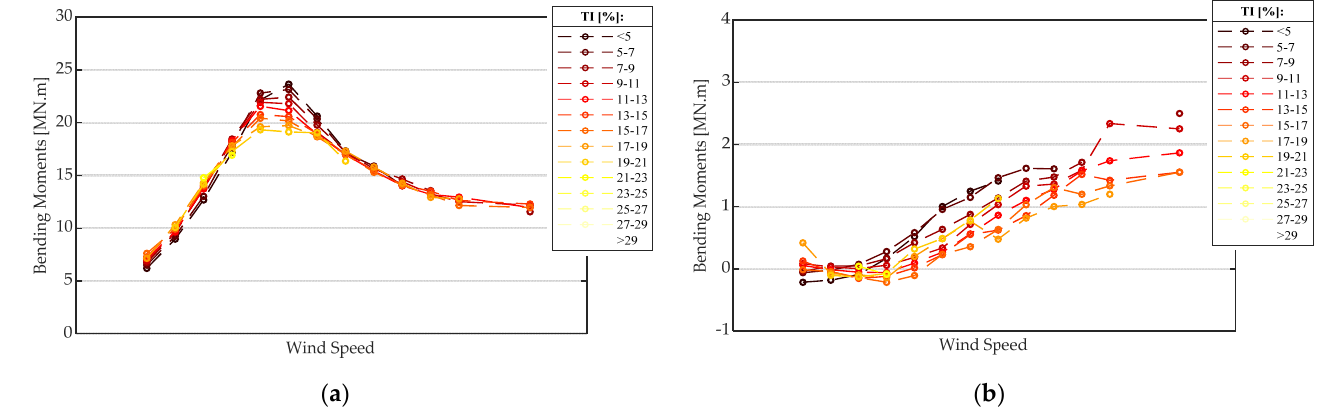
Figure 11. Variation of 10 min average bending moments at the tower base as a function of the wind speed and turbulence intensity, considering normal power production: ( a ) fore–aft direction, and ( b ) side-to-side direction (x scale omitted because of confidentiality agreements).